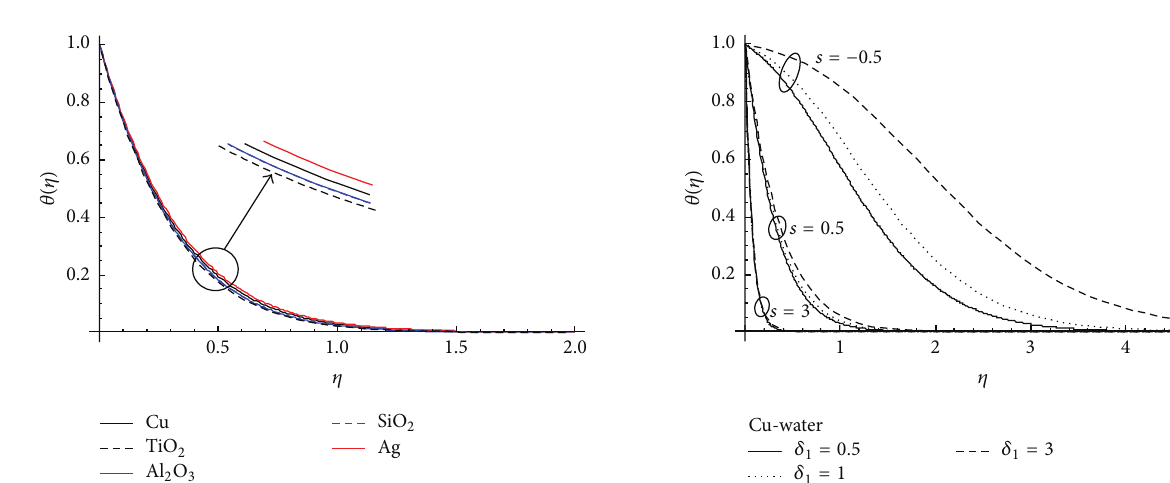
Figure 7: Effect of the first slip 𝛿 1 on temperature distribution 𝜃(𝜂) at different values of 𝑠 for Cu-water nanoparticles when 𝑃𝑟 = 6.2 , = 0 𝜙 = 0.1 , and 𝛿 2